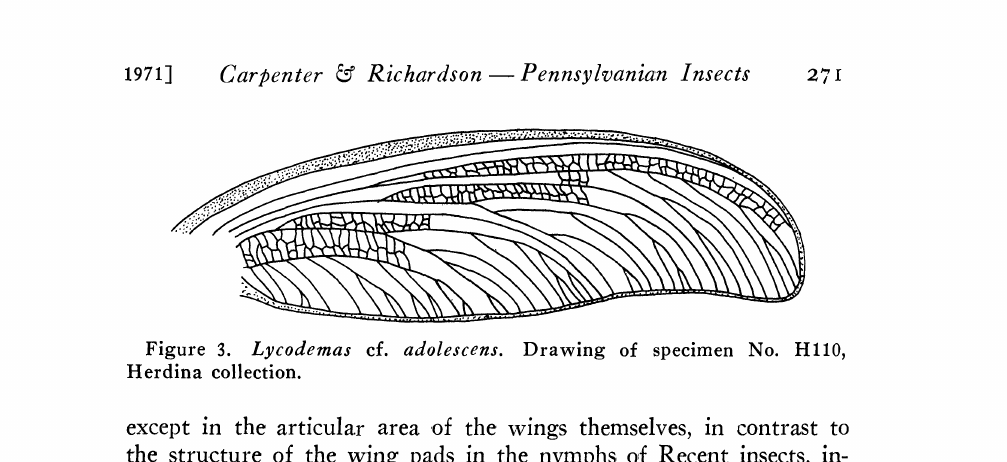
Figure 3. Lycodemas el. adolescens. Drawing of specimen No. Hll0, Herdina